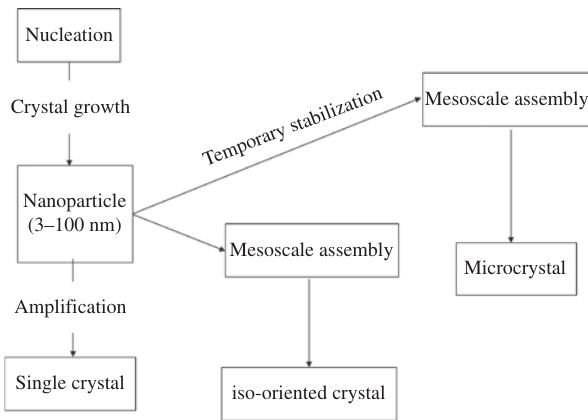
Figure 8: Schematic of aggregation-based nanoparticle crystalline